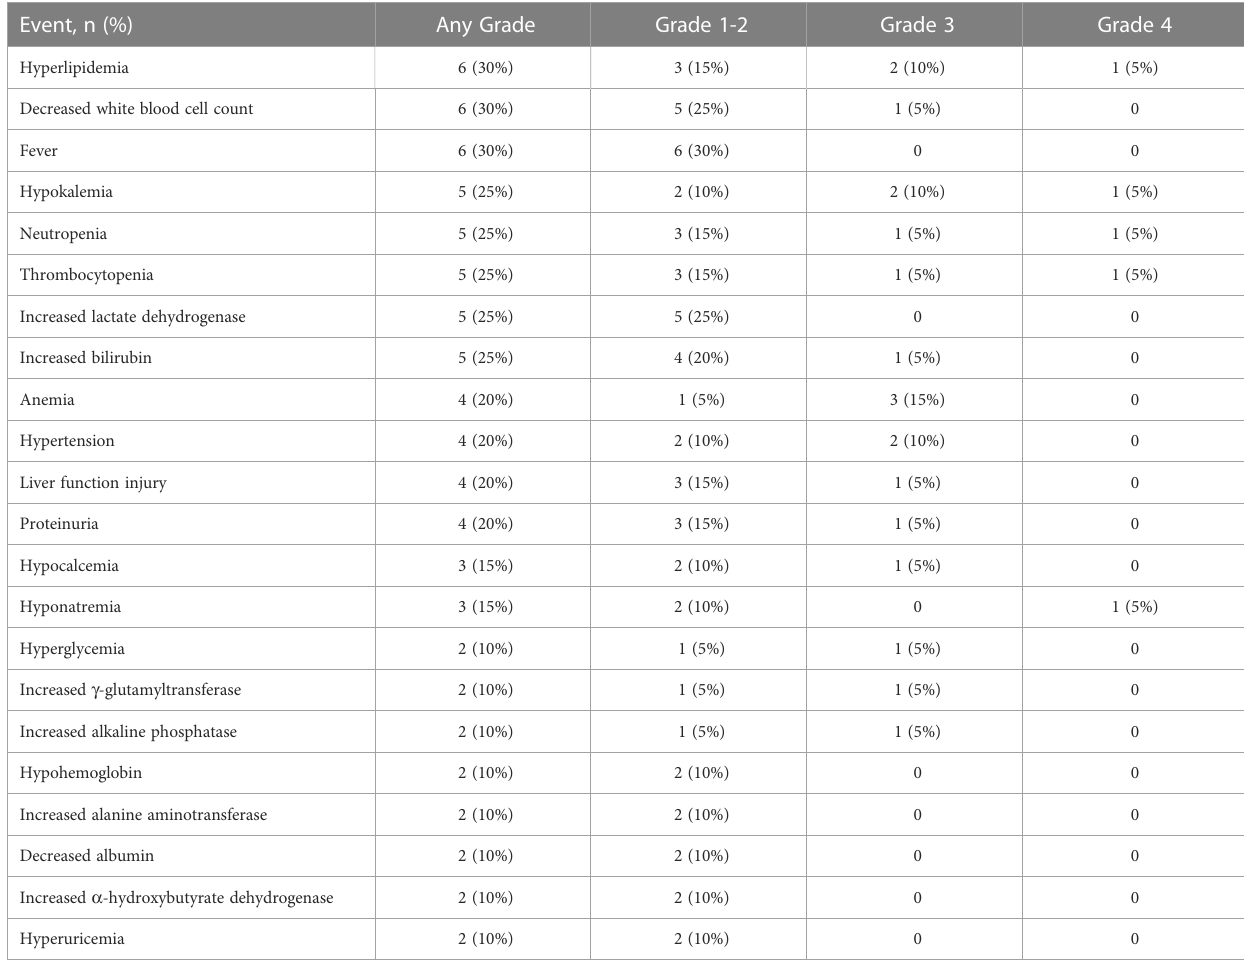
TABLE 4 Treatment related adverse events occurred in ≥ 10% of